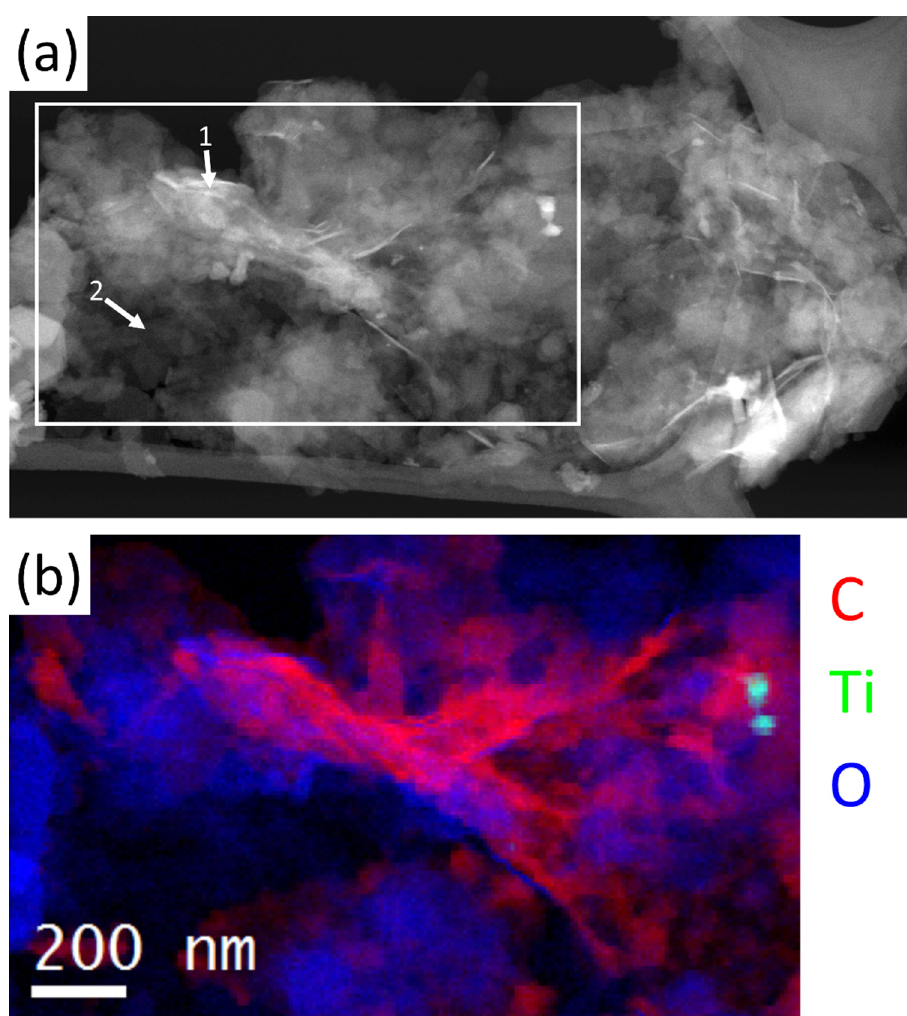
Figure 5. (a) High-resolution ADF-STEM image and ( b ) EELS elemental map for three elements (C, Ti, and O) acquired on sub-200 nm ultrafines fraction of contaminant solids. The EELS map shown in ( b ) is taken from the region identified by the white rectangle in ( a ). The RGB contrast consists of: red = carbon, green = titanium, and blue = oxygen.